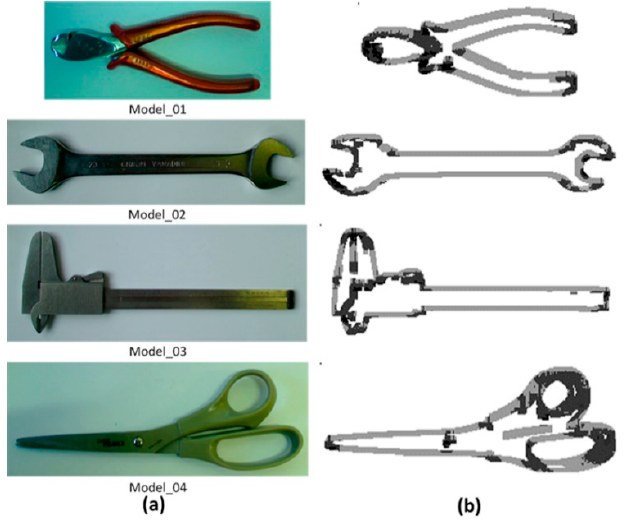
Figure 5. Regional weight of model. ( a ) The original model; ( b ) The deeper color of the pixel where the weight value is bigger.